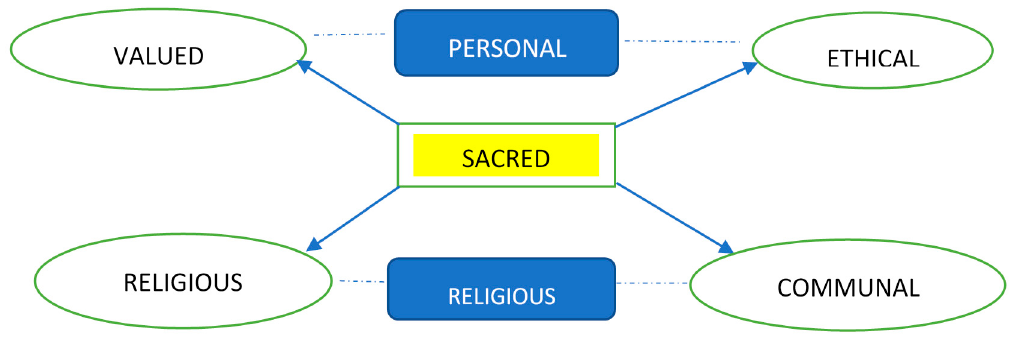
Figure 1. Students’ attitude towards Religion (Baring et al. 2018).